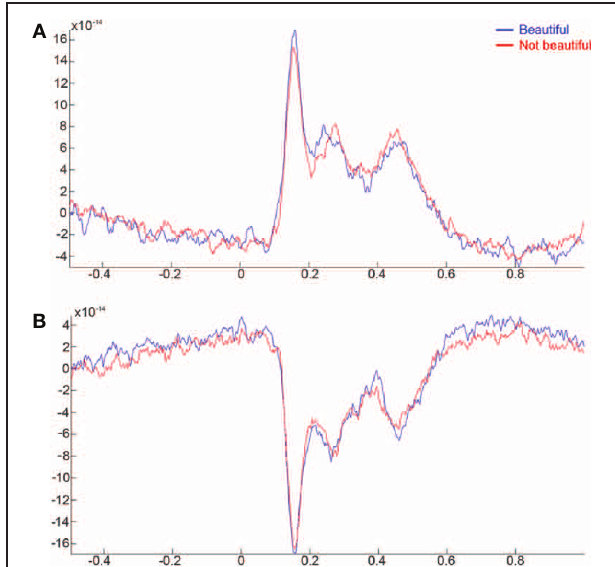
FIGURE 2 | Time course of activity in the right and left hemispheres related with “beautiful” and “not beautiful” stimuli from 500ms prior to the stimulus onset to 1000 ms post-stimulus. (A) Average activity of the 108, 109, 110, 111, 126, 127, 128, 129, 144, 145, 146, 147, and 148 right sensors. (B) Average activity of the 96, 97, 98, 99, 114, 115, 116, 117, 132, 133, and 134 left